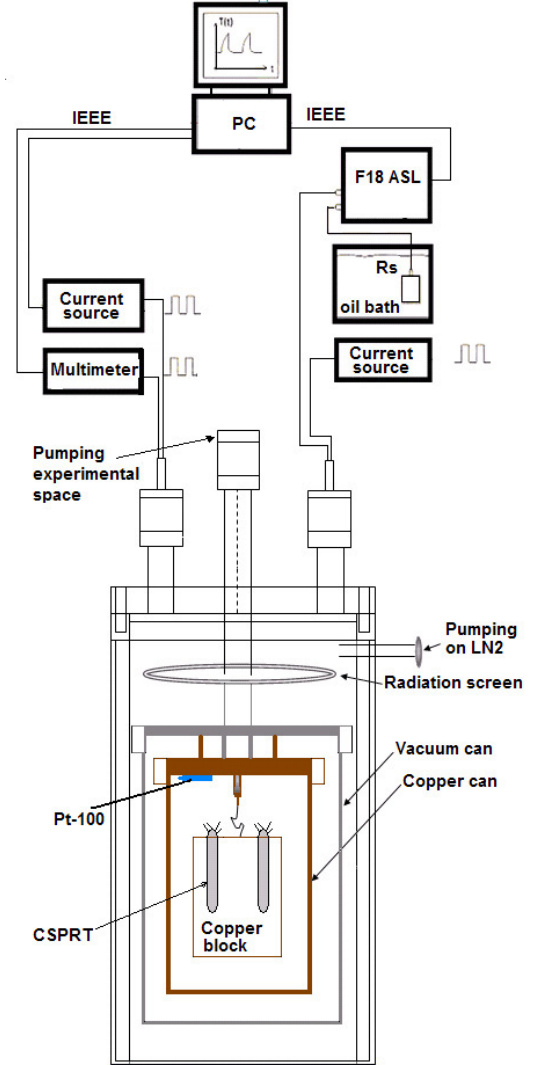
Fig. 1. Schematic side view of the comparison cryostat.